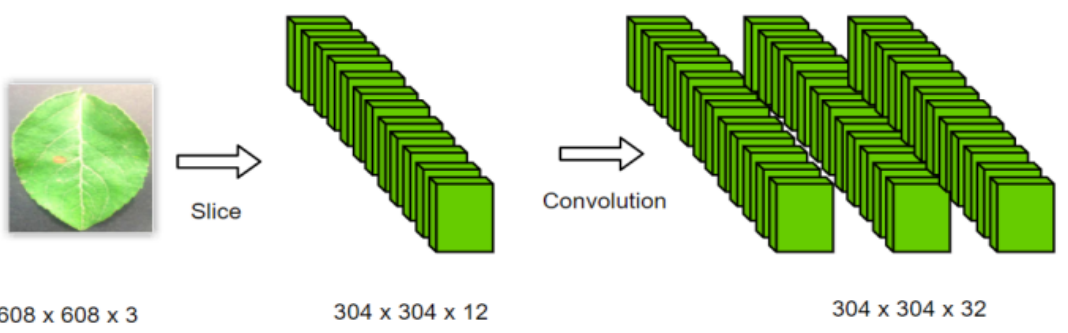
Figure 5. Slicing process of the